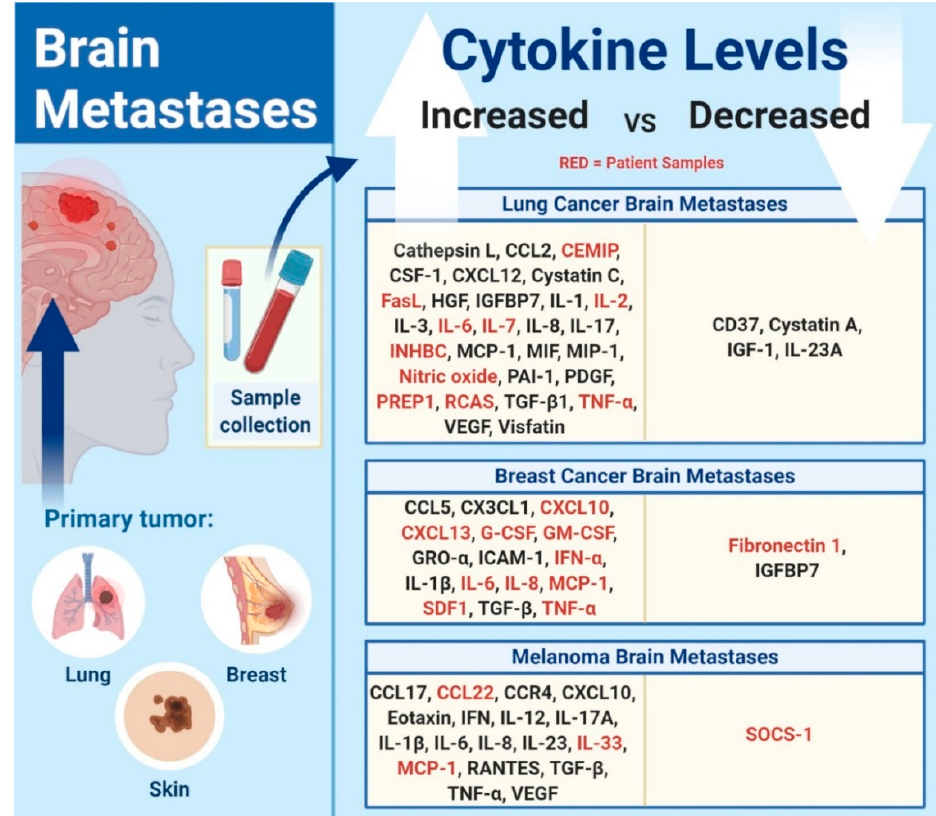
Figure 1. Cytokine and chemokine levels in brain metastases. Identifying the different levels of cytokines and chemokines in brain metastases from different primary tumors allows for the differentiation between patients with and without brain metastases. Red-colored cytokines correspond to studies that are based on patient samples.